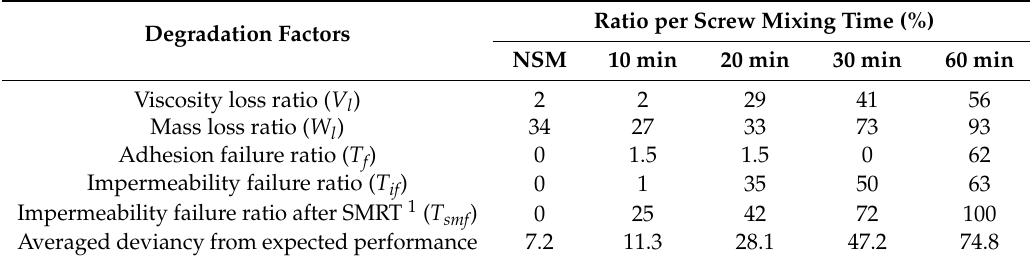
Table 10. Estimation of the deviancy from the expected performance of SPRG (3 days storage).